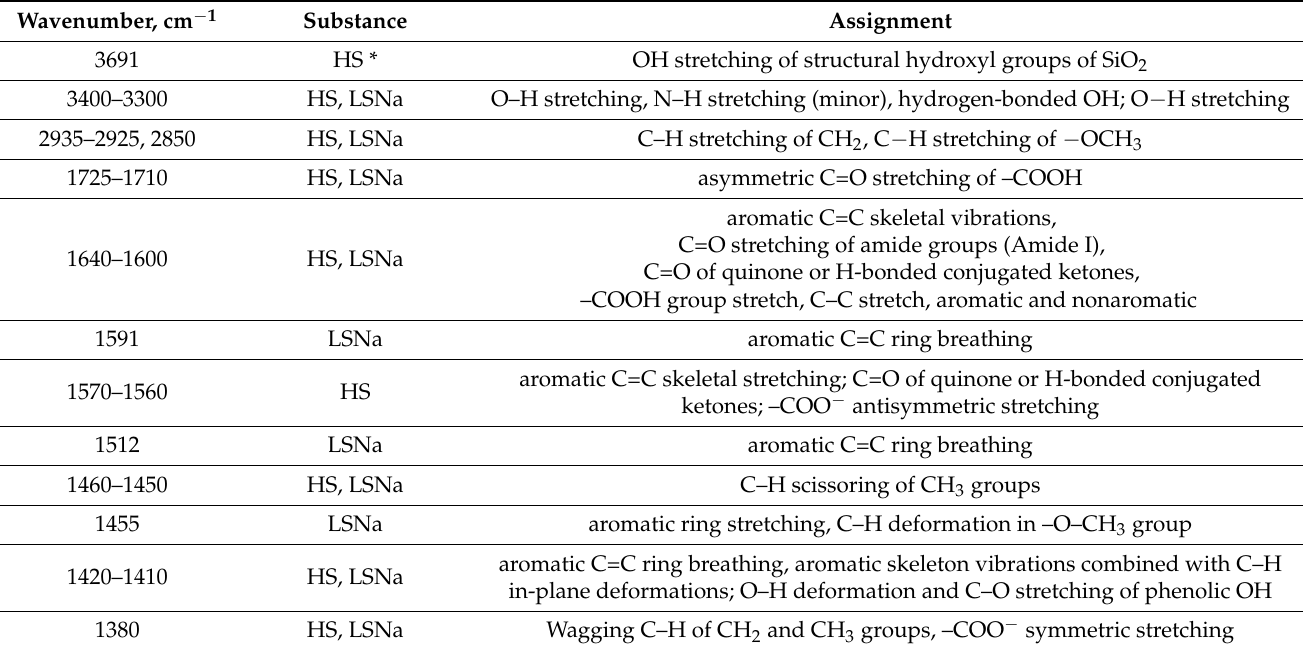
Table 1. Absorption bands of dry sodium lignosulfonate (LSNa) and humates (HS) and their aqueous solutions